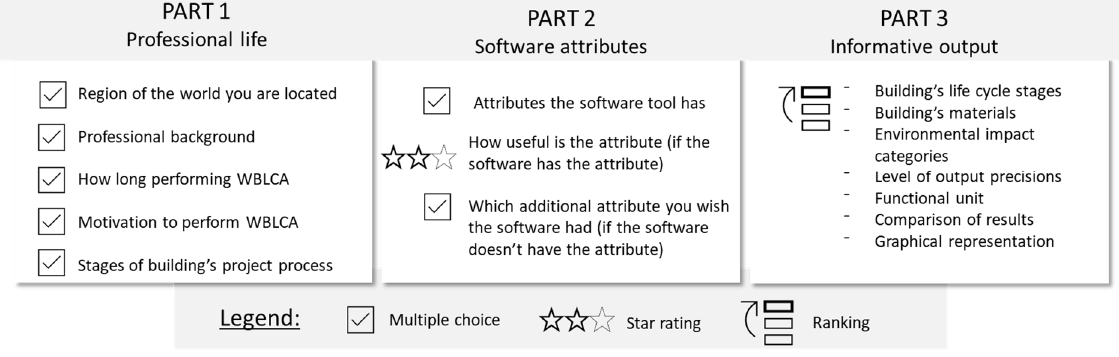
Figure 1. Survey flow.